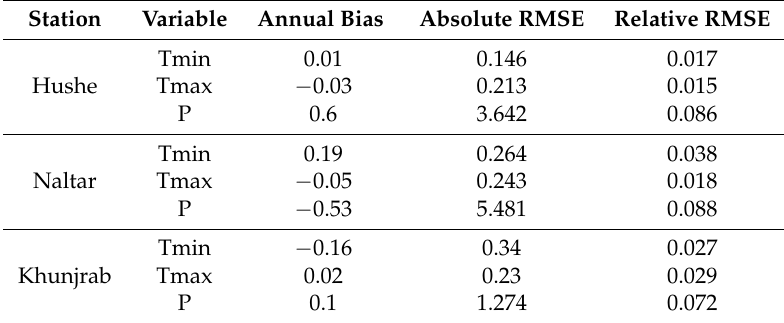
Table 6. Performance of the LARS-WG against the observations